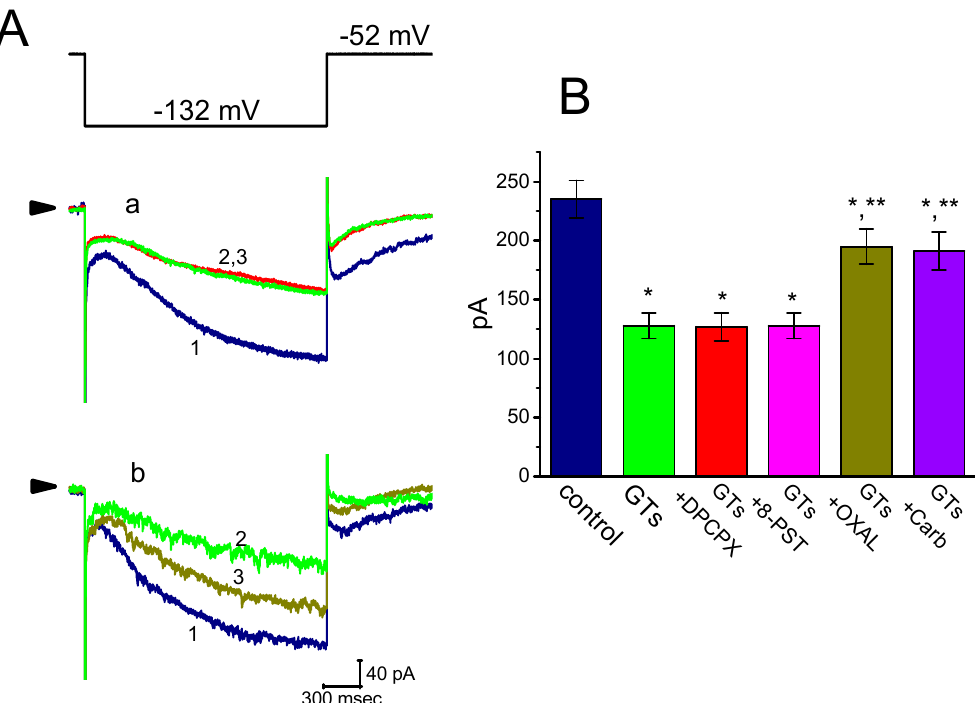
Figure 4. Comparisons among the effects of GTs, GTs plus 8-cyclopentyl-1,3-dipropylxanthine (DPCPX), GTs plus 8-( p -sulfophenyl)theophylline (8-PST), GTs plus oxaliplatin (OXAL) and GTs plus carboxiplatin (Carb) on I h amplitude in GH 3 cells. Current amplitude was taken at the end of 2-sec hyperpolarizing pulse to − 122 mV. (A) Superimposed I h traces elicited in response to step hyperpolarization (as indicated in the uppermost part). In panels a and b, current traces labeled 1 are controls and those labeled 2 were obtained in the presence of 10 µg/mL GTs alone, while in panel a or b that labeled 3 was, respectively, taken in the addition of 1 µM DPCPX (a) or 10 µM oxaliplatin (b), but still in continued presence of 10 µg/mL GTs. Arrows in current traces of each panel indicate the zero current level, and calibration mark shown in the right lower corner applies all current traces. (B) Summary bar graph showing the effects of GTs (10 µg/mL), GTs plus DPCPX (1 µM), GTs plus 8-PST (10 µM), GTs plus oxaliplatin (10 µM) and GTs plus carboxiplatin (10 µM) on I h amplitude measured from GH 3 cells (mean ± SEM; n = 6–9 for each bar). Current amplitude was obtained at the end of hyperpolarized pulse from − 52 to − 122 mV. DPCPX: 1 µM 8-cyclopentyl-1,3-dipropylxanthine; 8-PST: 10 µM 8-( p -sulfophenyl)theophylline; OXAL: 10 µM oxaliplatin; Carb: 10 µM carboxiplatin. *Significantly different from control ( p < 0.05) and ** significantly different from 10 µg/mL alone group ( p < 0.05).